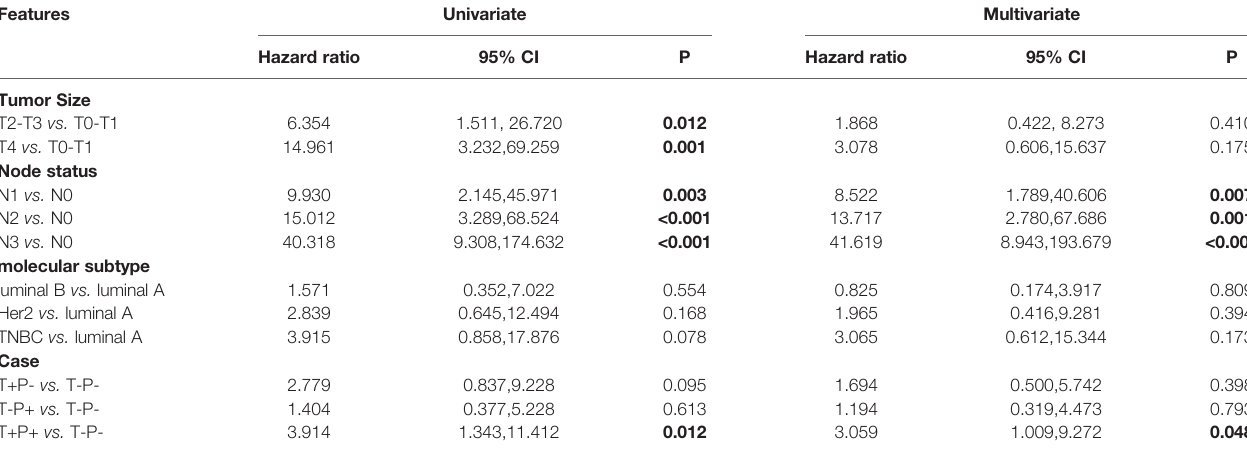
TABLE 6 | Overall survival of patients diagnosed with breast